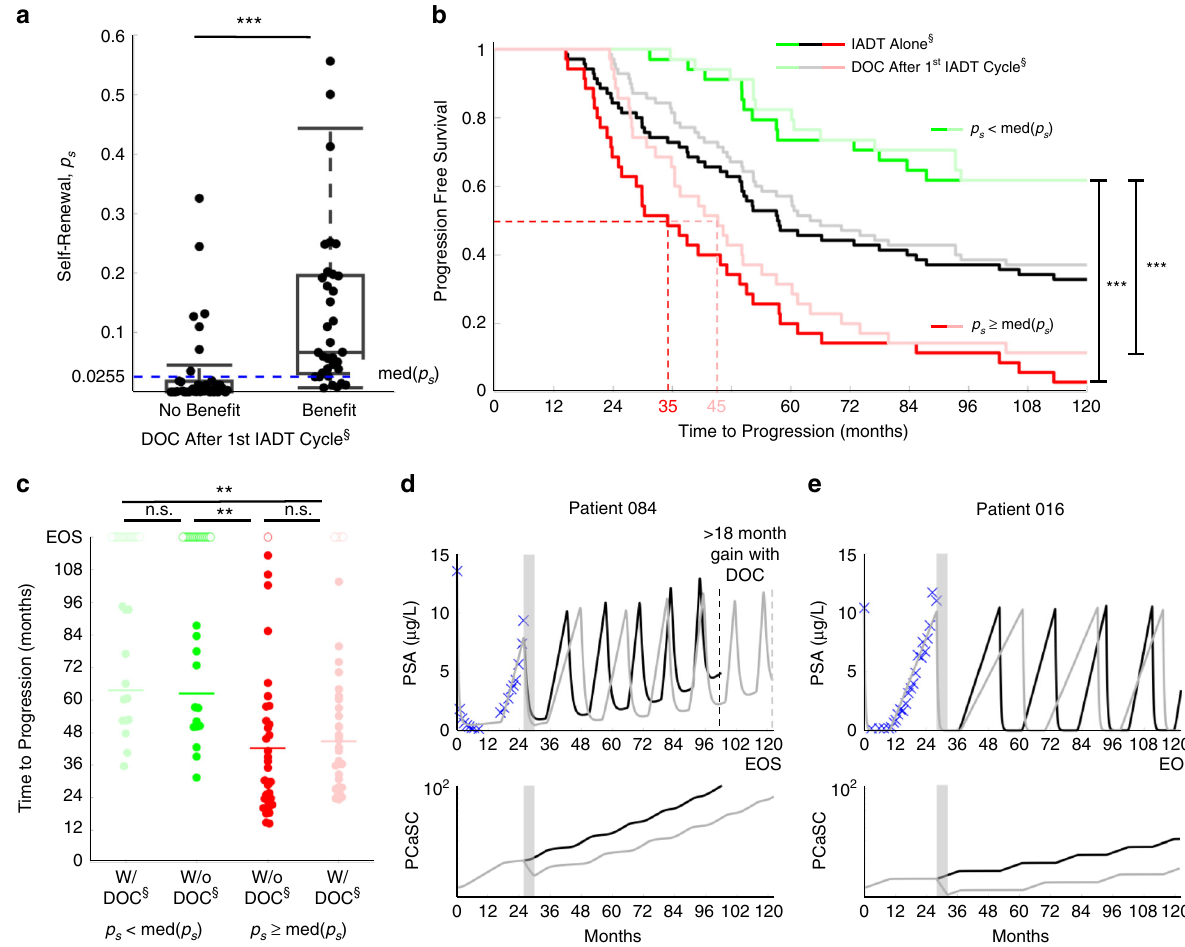
Fig. 8 First cycle p s strati fi es patients who could bene fi t from docetaxel after fi rst cycle of IADT. a p s distributions between patients who may bene fi t from docetaxel after fi rst cycle of IADT and those who may not. Median p s (shown by blue dashed line) strati fi es patients who could bene fi t from docetaxel after fi rst cycle of IADT. The two-sample t test was used to calculate the statistical signi fi cance of the difference between patients receiving no bene fi t ( n = 36) and bene fi t ( n = 34) from docetaxel after fi rst cycle. Boxplots show median including the 25th and 75th percentiles. The two-sample t test was used to calculate the statistical signi fi cance of the difference between the two groups ( p = 0.0004). b Kaplan – Meier estimates of progression with and without docetaxel after fi rst cycle of IADT (double S indicates predictive model simulation). Stratifying by median p s shows that patients with p s ≥ med p s ð Þ (red) experience greatest bene fi t from docetaxel (gain of 10 months). For patients with p s < med p s ð Þ (green), there was not a signi fi cant bene fi t in TTP. Statistical signi fi cance was determined using logrank test. c TTP comparison between IADT with and without docetaxel. Open circles denote end of simulation (EOS). TTP was signi fi cantly shorter in patients with p s ≥ med p s ð Þ both with and without docetaxel. Solid lines denote mean TTP (63.57, 62.35, 42.26, and 44.77 months (left to right) for patients with low p s (green) and high p s (red), respectively). d – e Simulation results of IADT with (gray) and without (black) docetaxel after fi rst cycle. d Patient 084 p s ¼ 0 : 0386 > med p s ð Þð Þ gains at least 18 months with docetaxel after fi rst cycle. e Patient 016 p ¼ 0 : 0017 < med p ð Þð Þ did not progress with or without docetaxel. In a – c , double and triple star signi fi es p < 0.01 and p < 0.001, s s